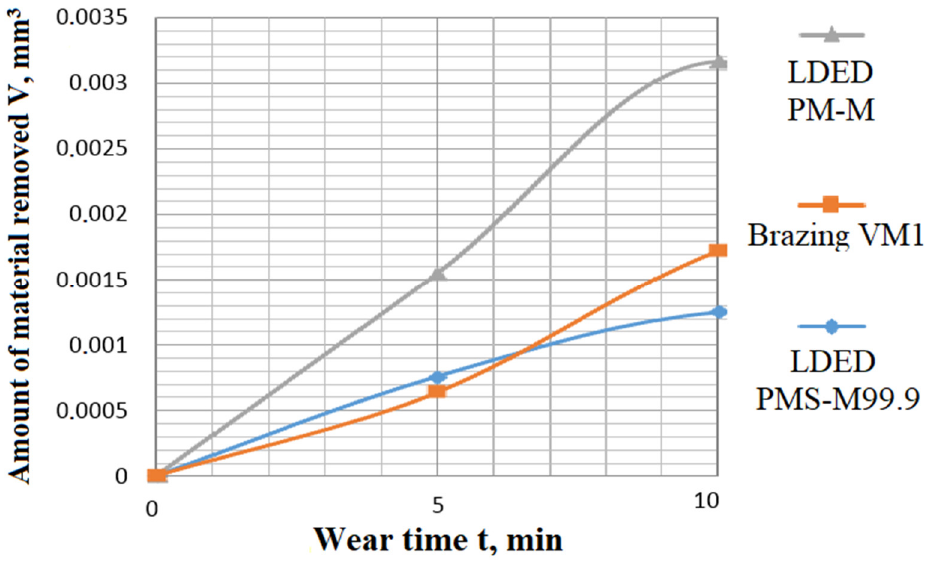
Figure 16. The 3D imaging of contact spot after 10 min of abrasive wear tests: ( a ) LDED of PMS-M99.9 powder, ( b ) brazing, and ( c ) LDED of PM-M powder.